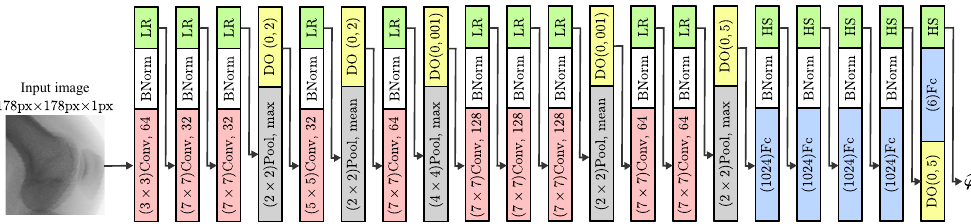
Figure 8. The optimal CNN architecture. Each rectangle represents one layer of CNN. The following colors are used to distinguish important elements of the network: blue (fully connected layer), green (activation functions, where HS stands for hard sigmoid, and LR denotes leaky ReLU), pink (convolution), purple (pooling), white (batch normalization), and yellow (dropout).